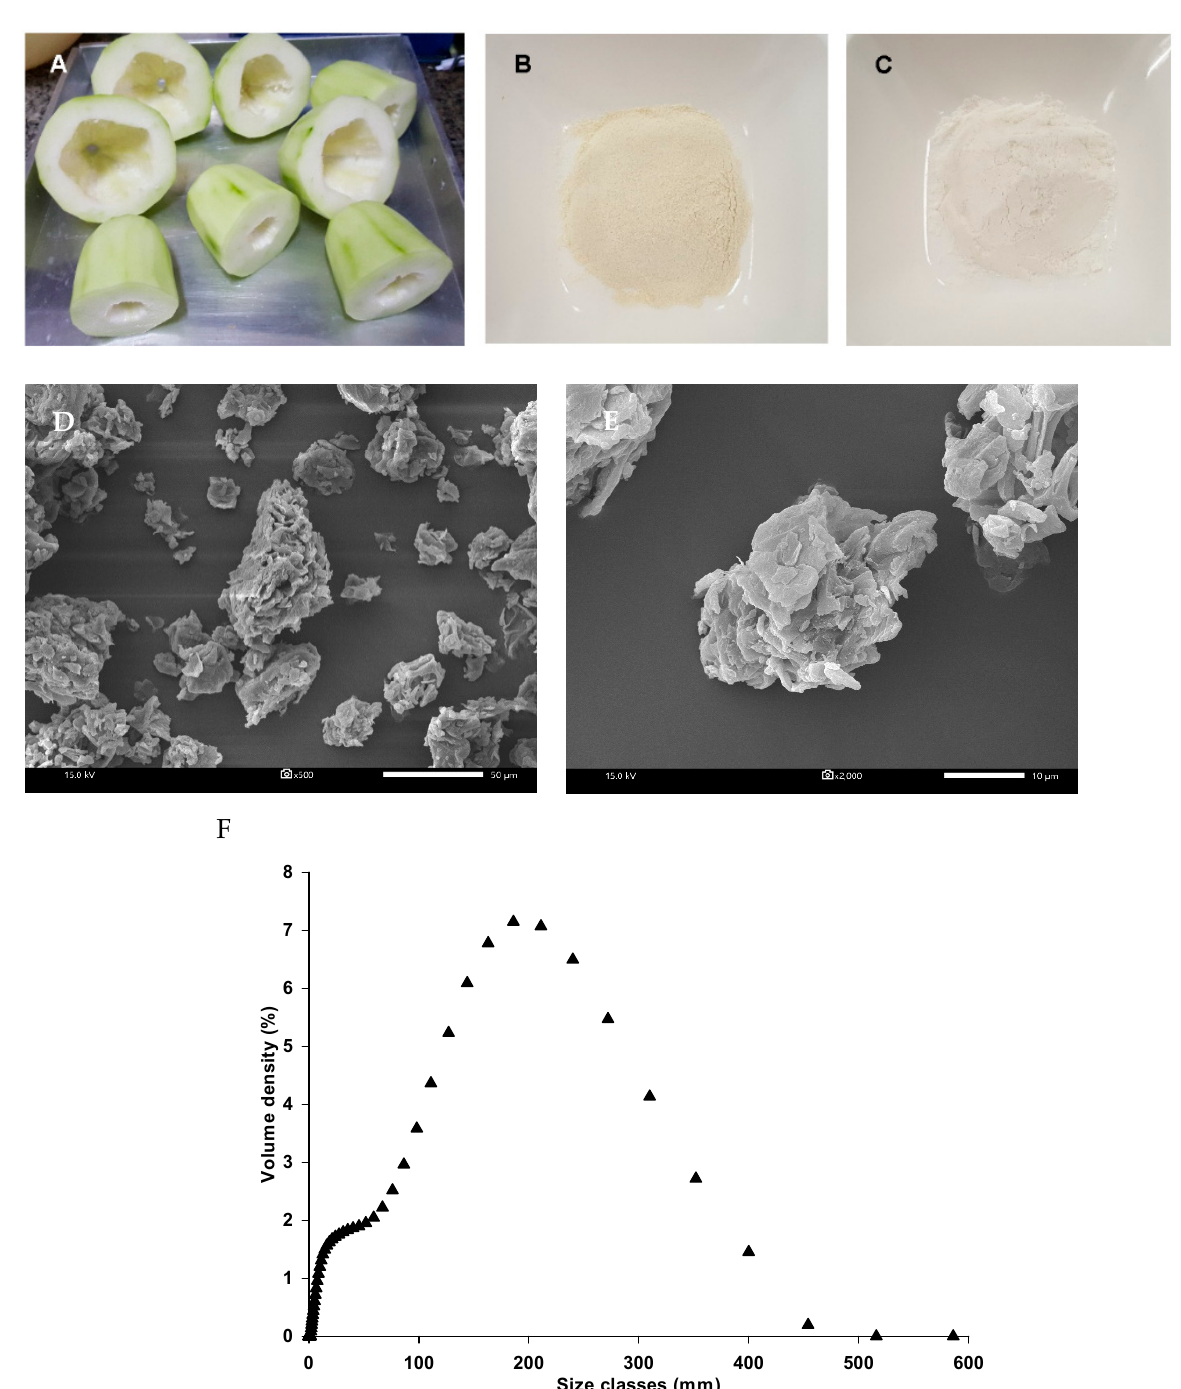
Figure 1. ( A ) Photographs of the top and bottom part of unripe papaya waste. The appearance of UPP ( B ) and wheat flour ( C ). Scanning electron micrograph of UPP magnified at ( D ) 500× and ( E ) 2000×. ( F ) Particle distribution by volume density of unripe papaya powder (UPP).